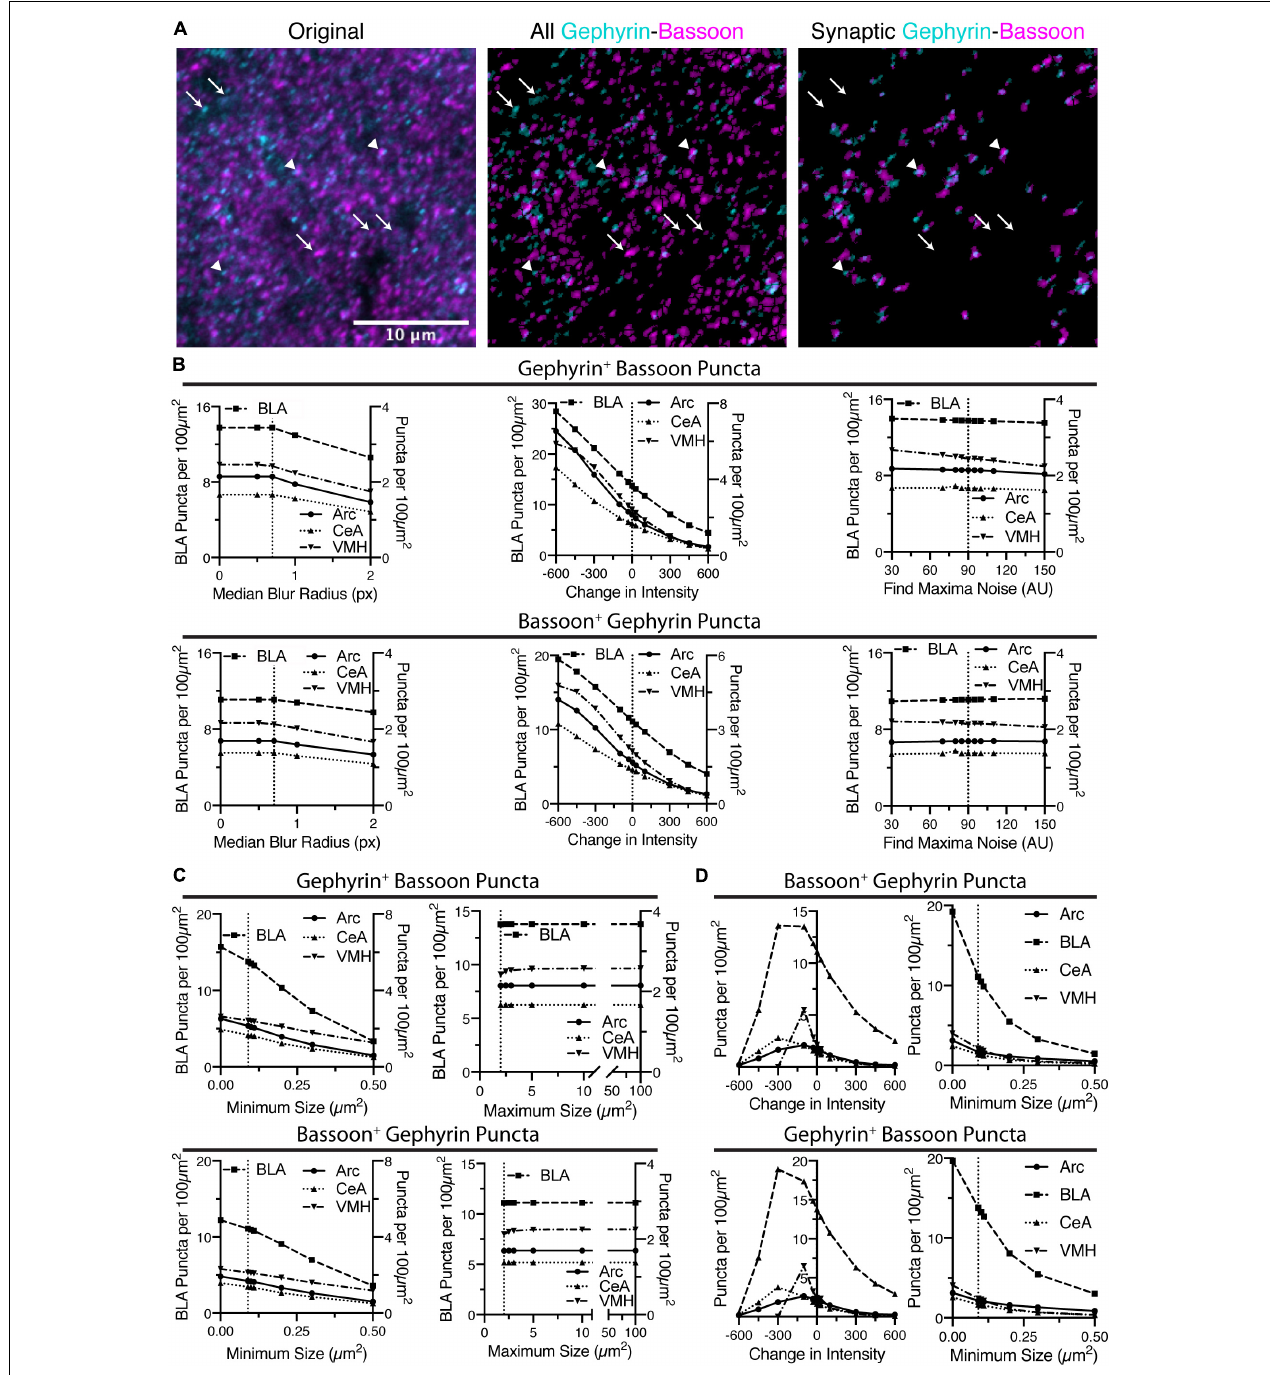
FIGURE 4 | Identification of putative synapses is done by finding overlap between puncta identified in the two images. (A) In the following sequence of images, gephyrin is colored in cyan and bassoon colored in magenta. Shown is the original two channel image, all of the identified puncta in both channels, and then the final identification of overlapping puncta. Some puncta are eliminated (identified with white arrows), while remaining, overlapping puncta are putative synaptic contacts (identified with white arrowheads). Scale bar, 10 µ m, applies to all images. (B) Increasing the threshold intensity for bassoon puncta reduces synaptic puncta density, for either gephyrin-positive bassoon puncta or bassoon-positive gephyrin puncta. Increasing radius for median blur or the noise value for “Find Maxima” cause relatively little changes in synaptic puncta density. Trends in synaptic puncta density are largely similar between brain regions. (C) Increasing minimum size of synaptic puncta decreases puncta density across all brain regions, while increasing maximum size leads to little change in synaptic puncta density. (D) Similar to the dense puncta identification, using the sparse identification method leads to synaptic puncta being negatively correlated with changes in minimum size of puncta. However, decreasing the intensity threshold too much leads to a decrease in synaptic puncta density.